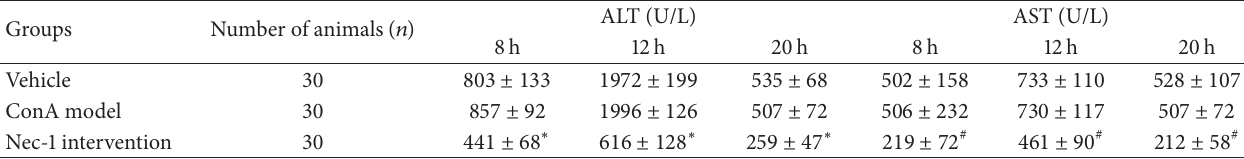
Table 5: Changes in liver function in ConA-induced hepatitis after the Nec-1 intervention (means ± SD).